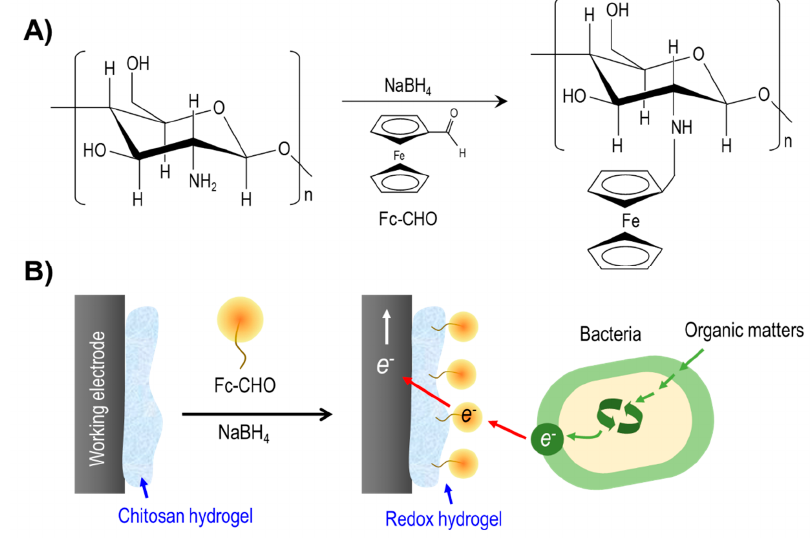
Figure 1. Schematic representation of preparation of redox-hydrogel-modified electrode. ( A ) Chemical structure of ferrocene-branched chitosan redox hydrogel. ( B ) Electrochemical interaction of redox-hydrogel-modified carbon cloth electrode with